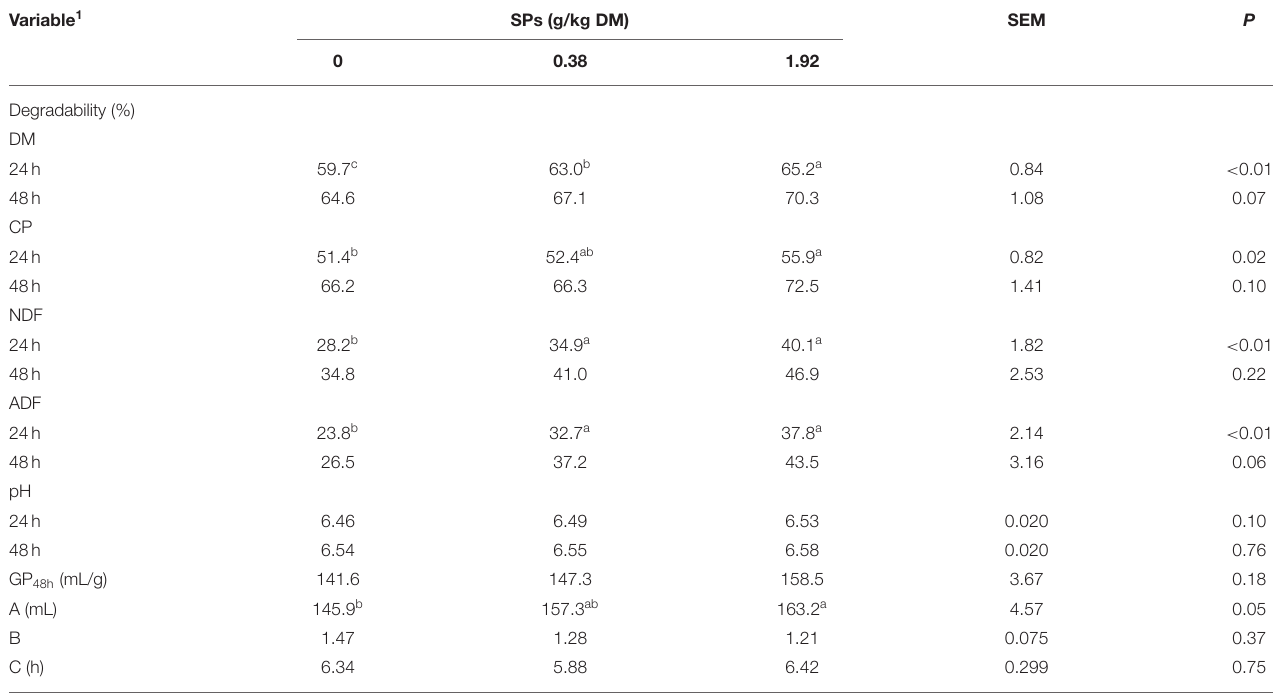
TABLE 3 | Effects of soybean peptides (SPs) on the in vitro degradability of DM, CP, NDF, and ADF, ruminal liquid pH, gas production, and kinetic parameters after 24 and 48h of incubation. Variable 1